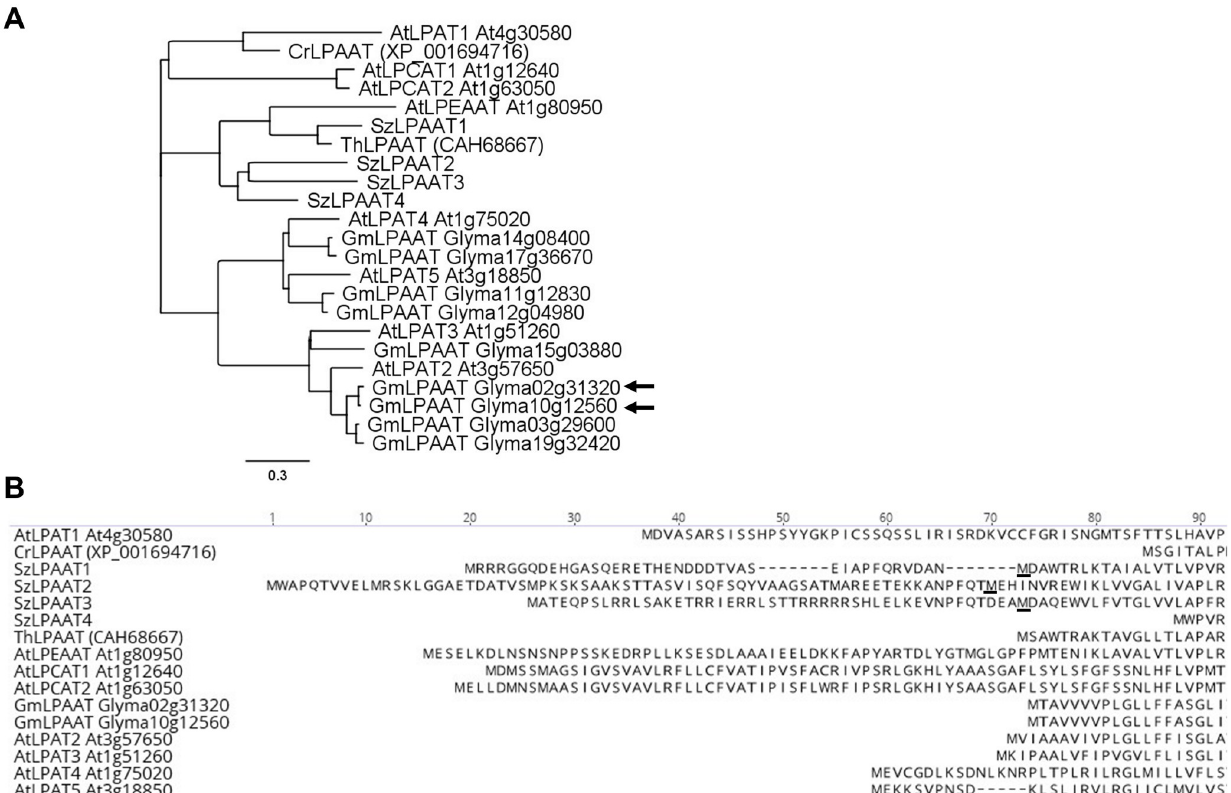
Fig 1. Comparison of LPAAT sequences. (A) Phylogenetic analysis of LPAATs using neighbor-joining method from a global alignment with free end gaps created in Geneious v9.1 (Biomatters). Arrows point to the GmLPAAT proteins further characterized in this study. At, Arabidopsis thaliana ; Cr, Chlamydomonas reinhardtii ; Gm, Glycine max ; Sc, Saccharomyces cerevisiae ; Sz, Schizochytrium sp.; Th, Thraustochytrium sp. (B) Multiple sequence alignment of plant and algal acyltransferase proteins. The underlined methionine residues indicate a potential start site for the SzLPAATs and were used as the initiation codon for the truncated